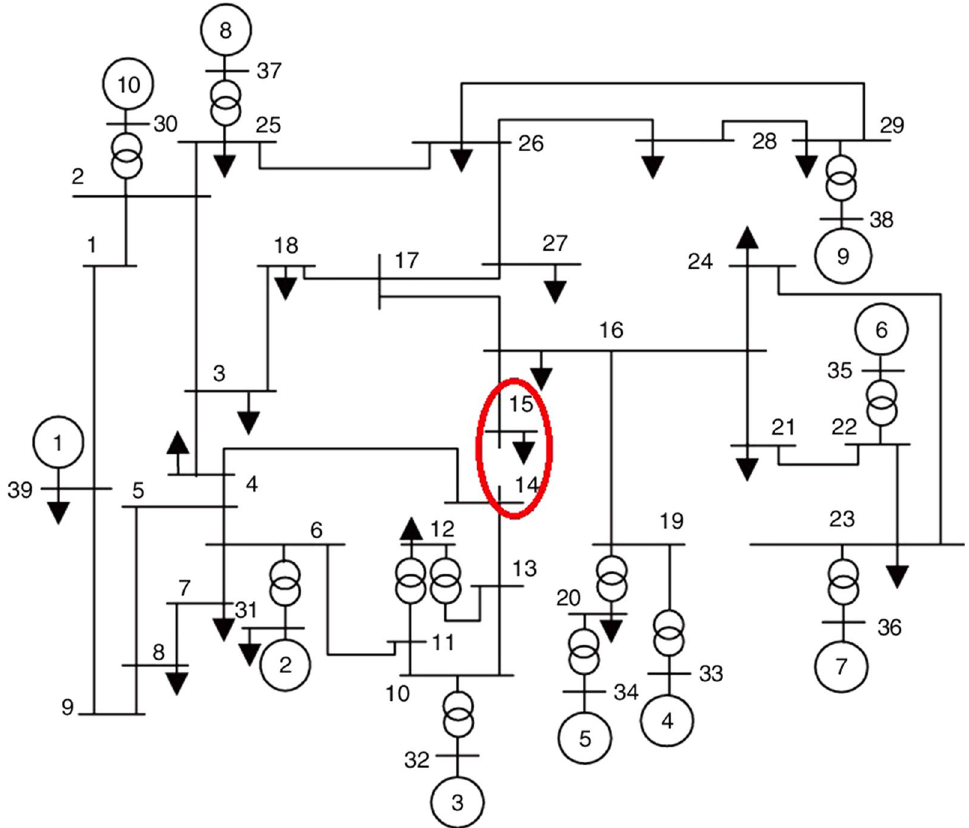
Fig. 10 Scenario 2 of case 2